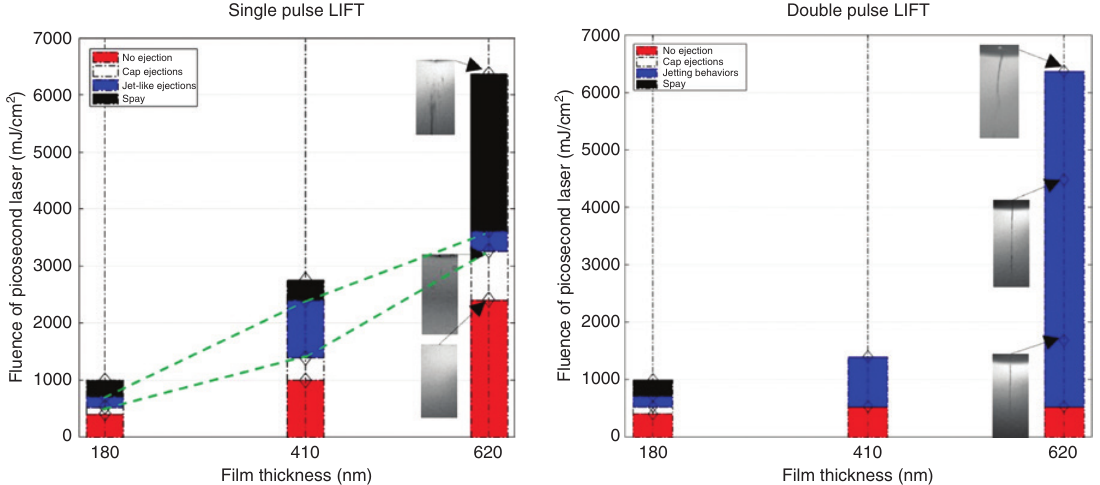
Figure 8: Regimes of ejection as a function of the ultrashort pulse laser fluence for the single-pulse LIFT and the double-pulse LIFT for three different thicknesses of the donor copper film.